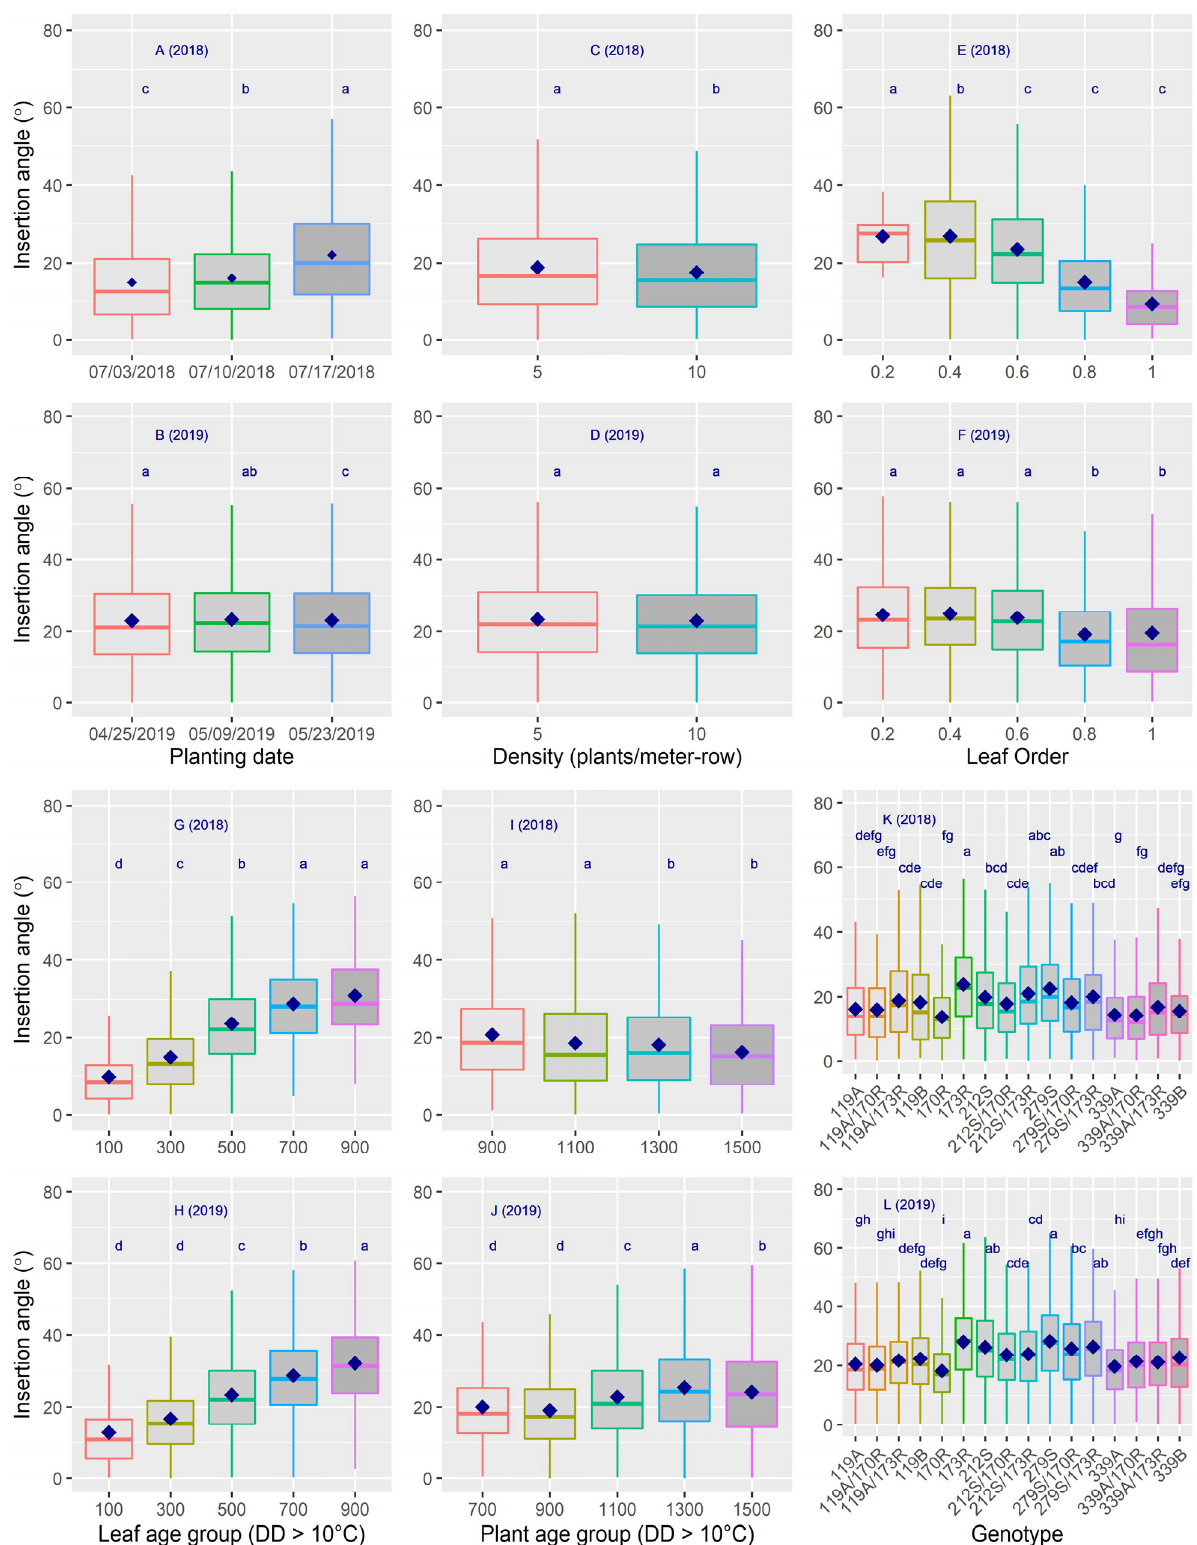
Figure 4. Leaf insertion angle in relation to planting date ( A ): 2018 and ( B ): 2019, density ( C ): 2018 and ( D ): 2019, leaf order ( E ): 2018 and ( F ): 2019, leaf age ( G ): 2018 and ( H ): 2019, plant age ( I ): 2018 and ( J ): 2019, and genotypes ( K ): 2018 and ( L ): 2019. For each plot, categories having the same lowercase letter are not significantly different from each other at 0.05 with Tukey’s HSD multiple comparison test.